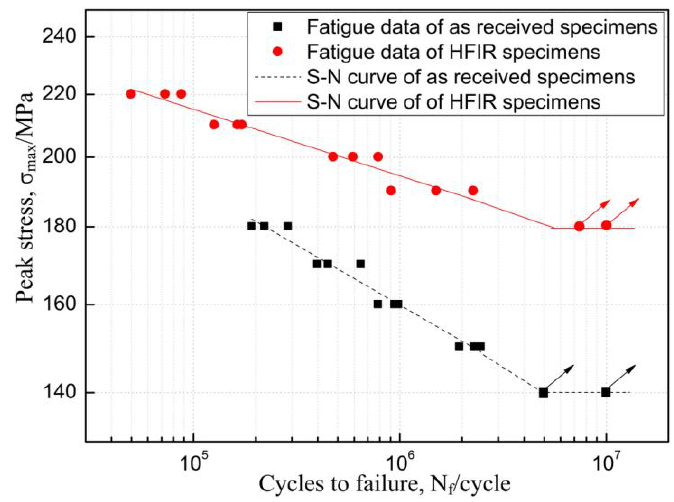
Figure 9. S - N curves of as-received and HFIR specimens.